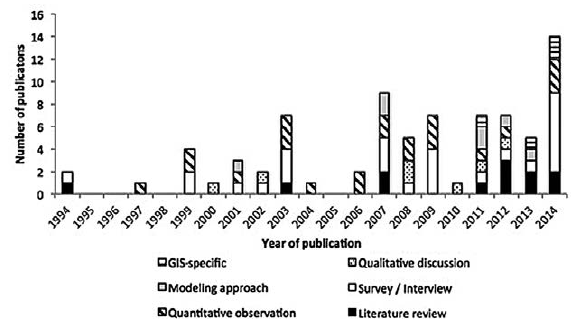
Fig. 2. – Numbers of publications highlighted in the literature search per year, separated by study type. Note: one publication from 1976 was not included in the figure.